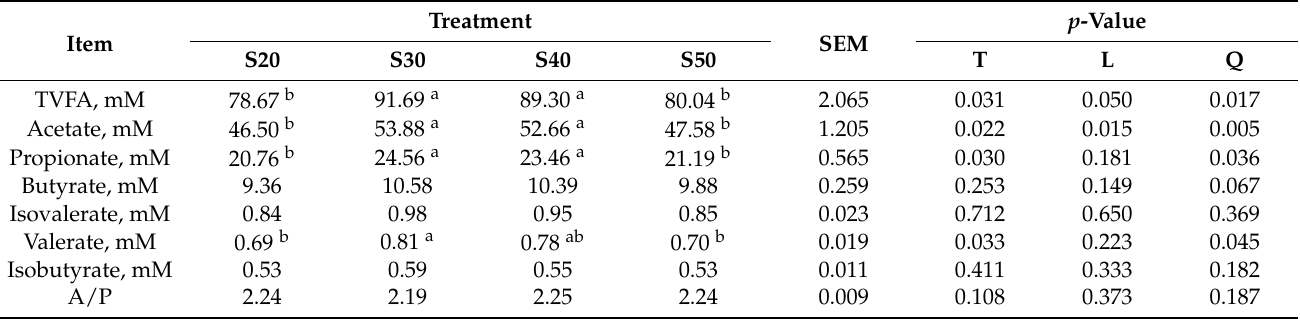
Table 5. The effect of substrate SP (% of CP) levels on volatile fatty acid (VFA) concentration at 24 h in